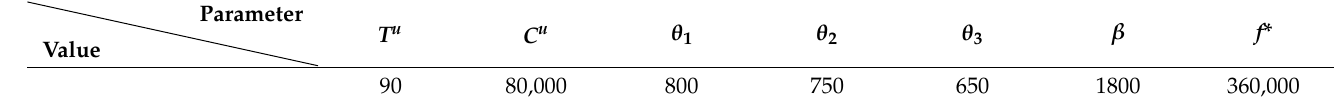
Table 6. Parameters of the project.